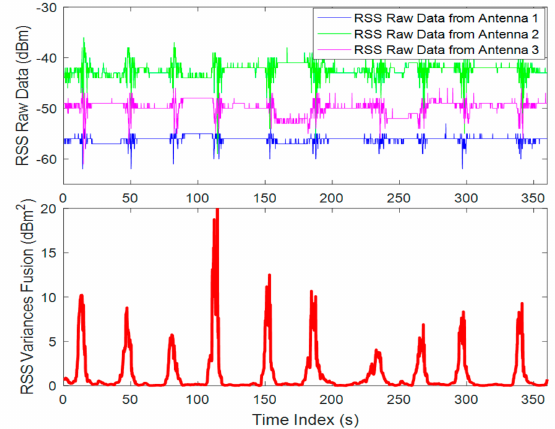
Figure 2. Diversity RSS fusion for RFT identification (RSS sampling rate: 10